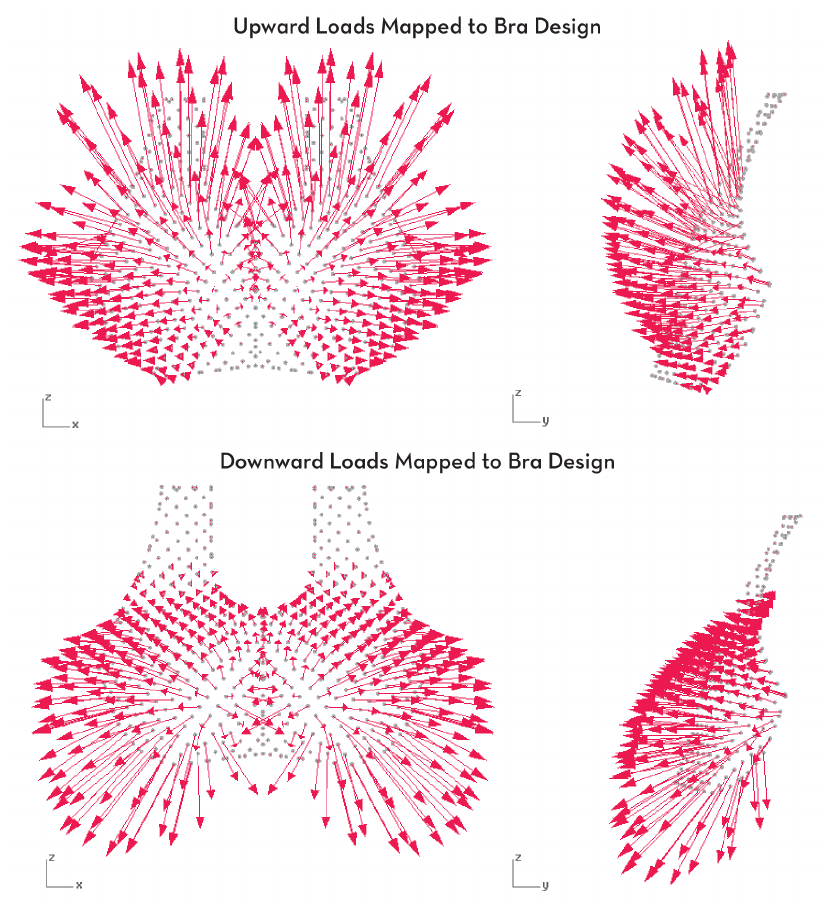
Figure 10. Visualization of vector loads mapped to bra from